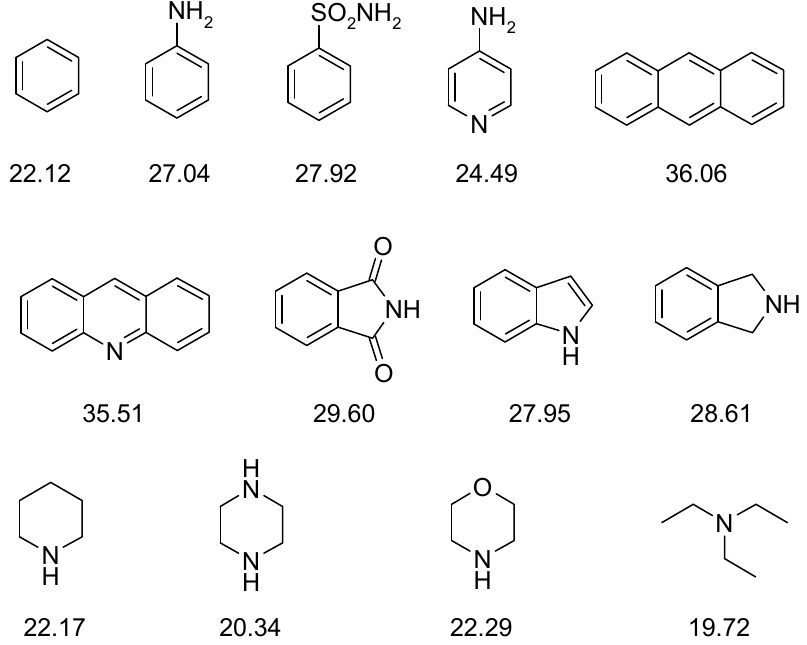
Figure 9. Structural fragments used for the fragment-based design of cholinesterase inhibitors. ChemScore values for binding with acetylcholinesterase are given for each